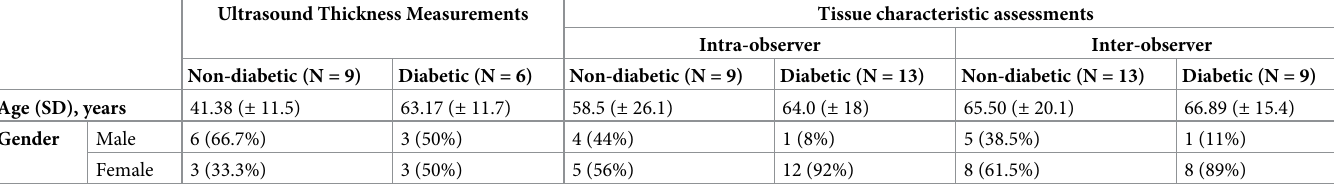
Table 1. Participant